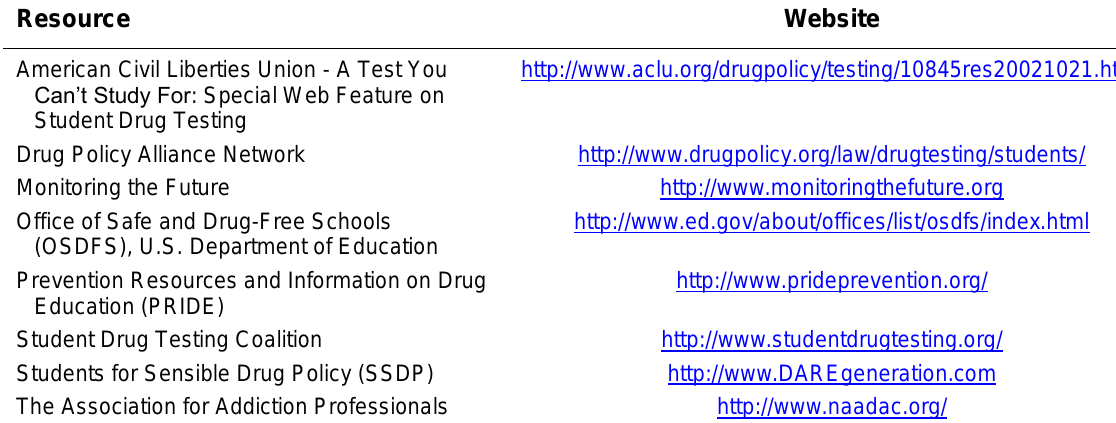
Internet Websites on School Drug